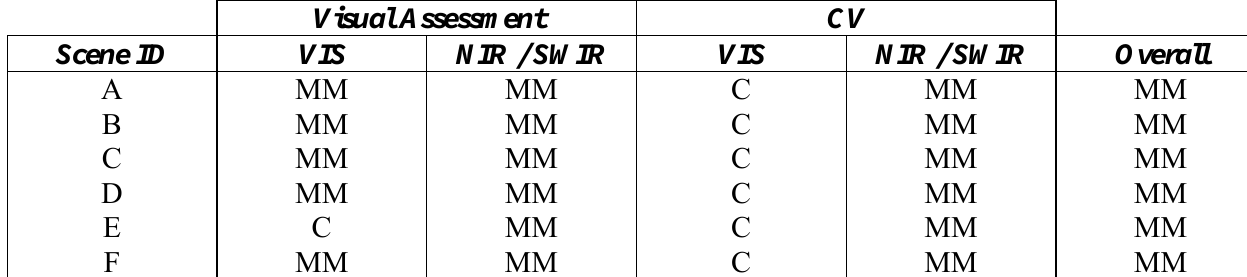
Table 2. Rankings for all